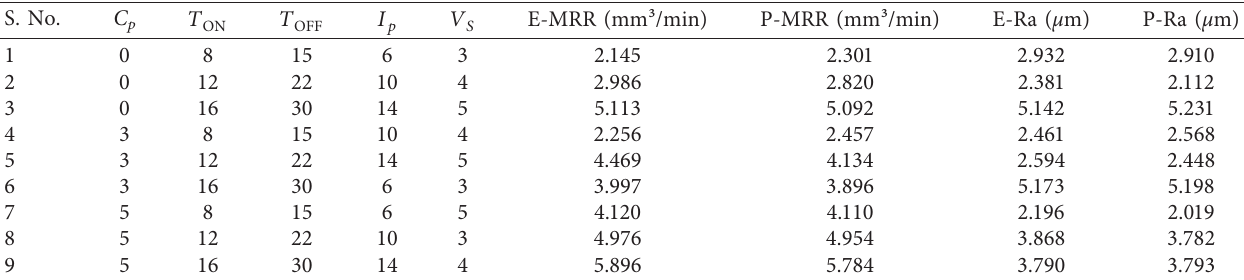
Table 9: Comparison of E-MRR and E-Ra with optimized values predicted using ANN model, i.e., P-MRR and P-Ra. S. No.